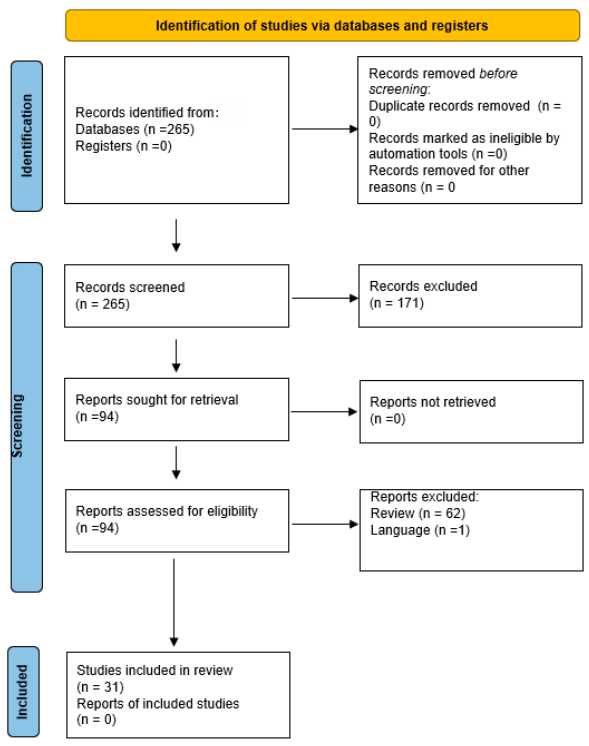
Figure 1. Flow diagram of the identification of studies via databases and registers.